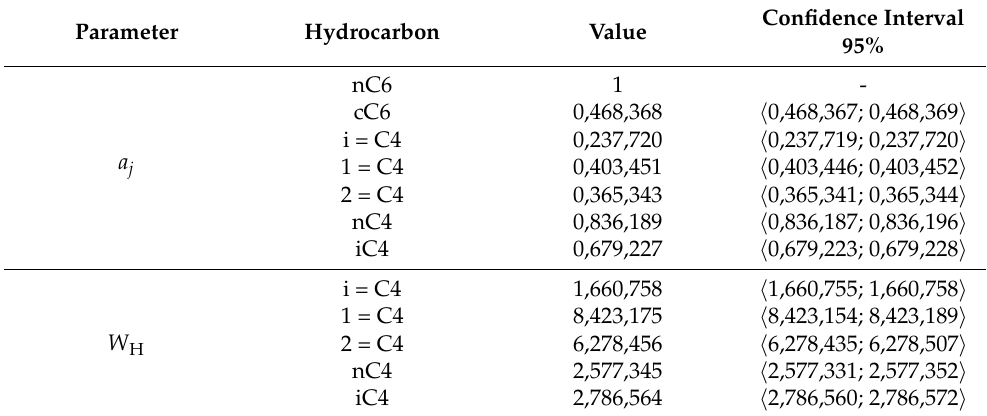
Table 4. Optimized parameter values obtained from regression analysis of experimental data accord- ing to Equation (3).